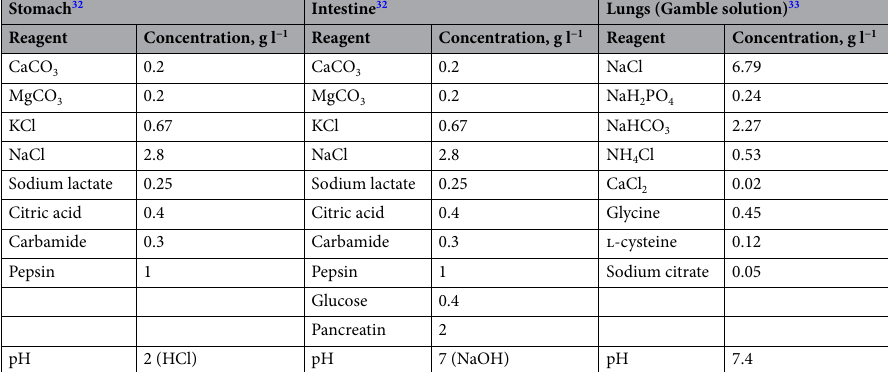
Table 1. Simulated human body fluids